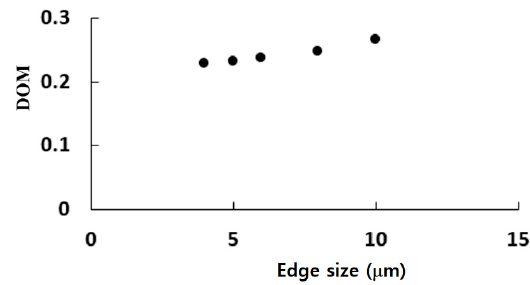
Figure 4. Variation of the DOM (degree of mixing) with the edge size of cells.